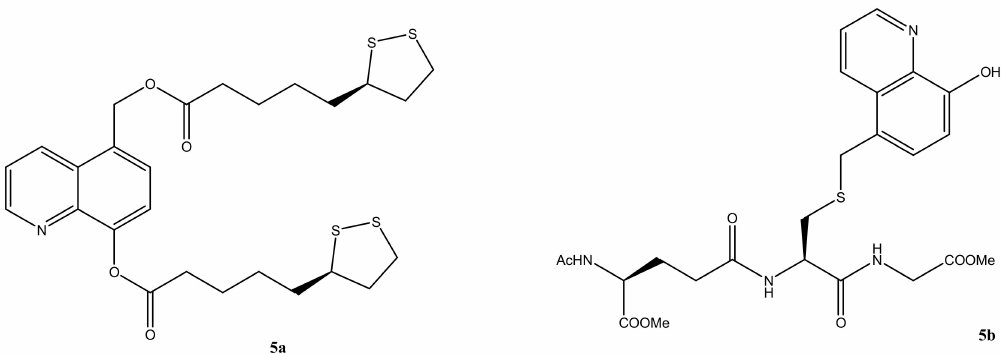
Figure 5. Structures of 8-hydroxyquinoline (8-HQ) analogs